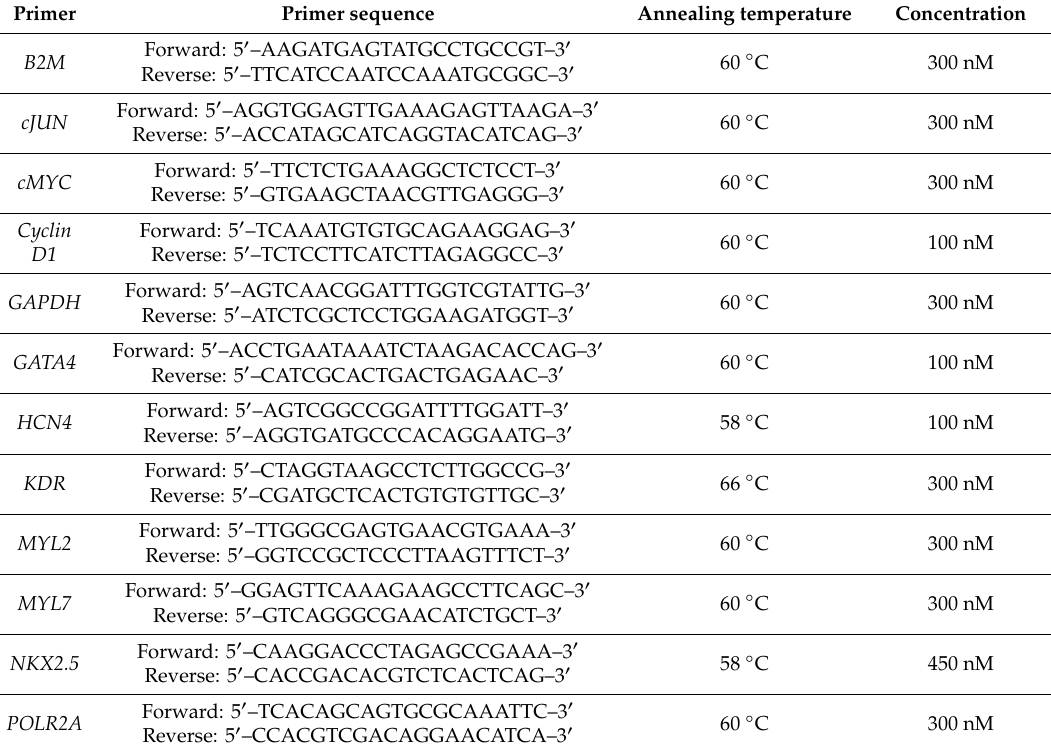
Table 4. Primer sequence, annealing temperature and